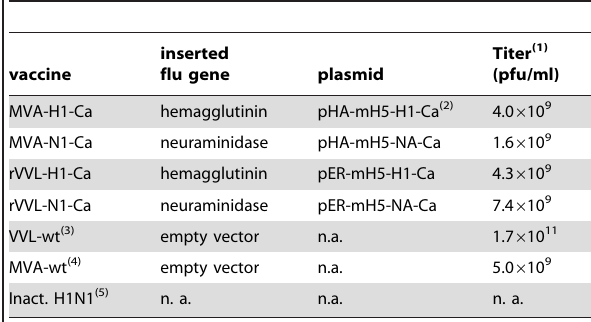
Table 1. Viruses, vaccine constructs and controls used in the